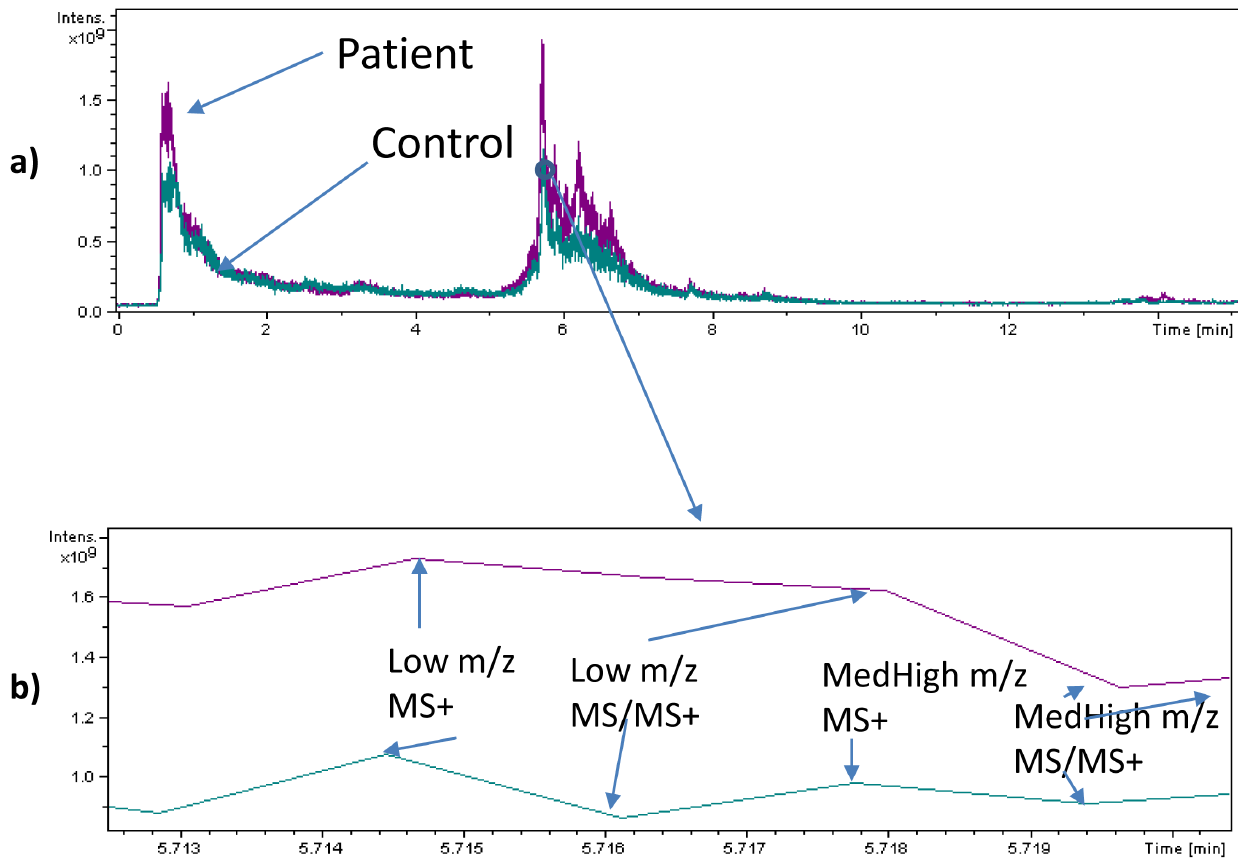
Figure 1. ( a ) Base peak LC Full Scan (MS), tandem mass (MS/MS) chromatogram of an extracted plasma sample of a patient and a control subject and ( b ) a blow-up of a specific chromatogram region (5.713–5.719 min). The blow-up shows the four regions of data acquisition: 1) Full scan mass spectrum originated by the cloud containing low m/z ratio molecular species; 2) Tandem mass spectra (MS/MS) mass spectrum originated by the cloud containing low m/z ratio molecular species; 3) Full scan mass spectrum originated by the cloud